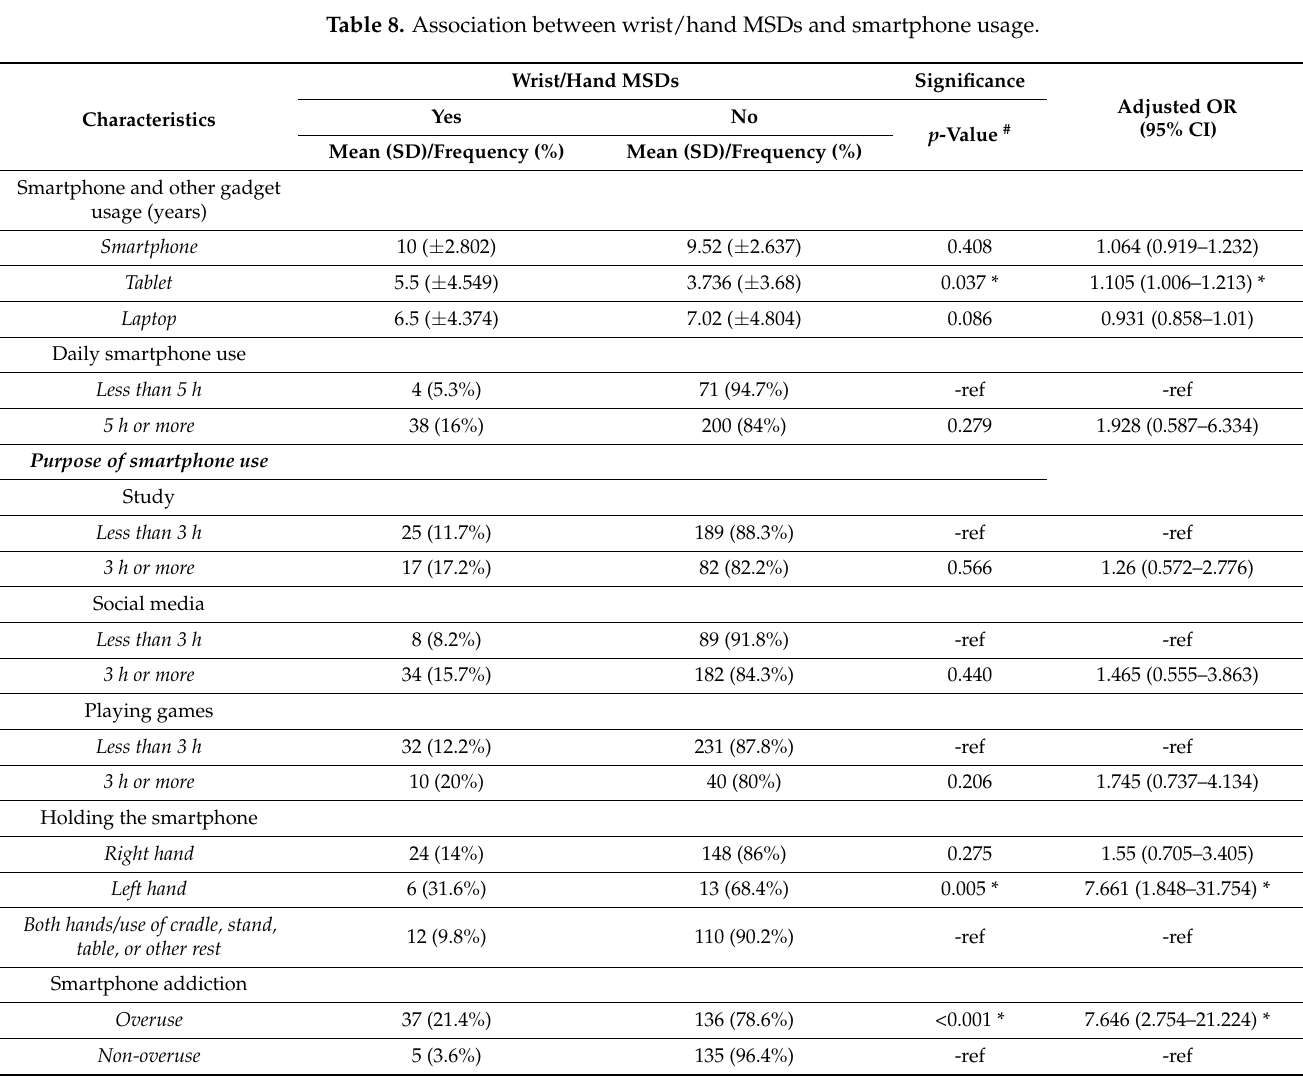
Table 8. Association between wrist/hand MSDs and smartphone